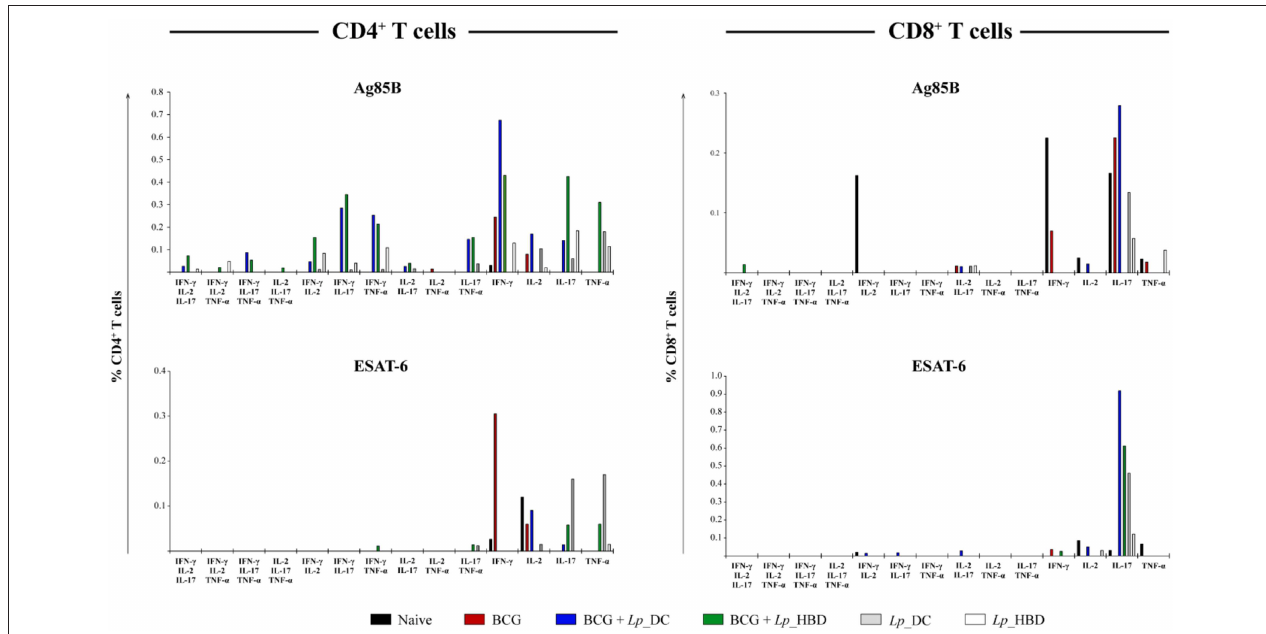
FIGURE 8 | Frequency of CD4 + and CD8 + T cells producing multiple pro-inflammatory cytokines. Splenocytes from immunized mice were stimulated with Ag85B or ESAT-6 in technical duplicates for 4h. Splenic T cells producing IFN- γ , IL-2, IL-17, and TNF- α cytokines were determined by intracellular staining using live → single cells → CD3 + → CD4 + /CD8 + → IFN- γ + /IL-2 + /IL-17 + /TNF- α + gating strategy. Thus, the frequencies of single-, double-, and triple- positive CD4 + and CD8 + T cells were determined. The data are presented from n = 2–3 pooled spleens per group.